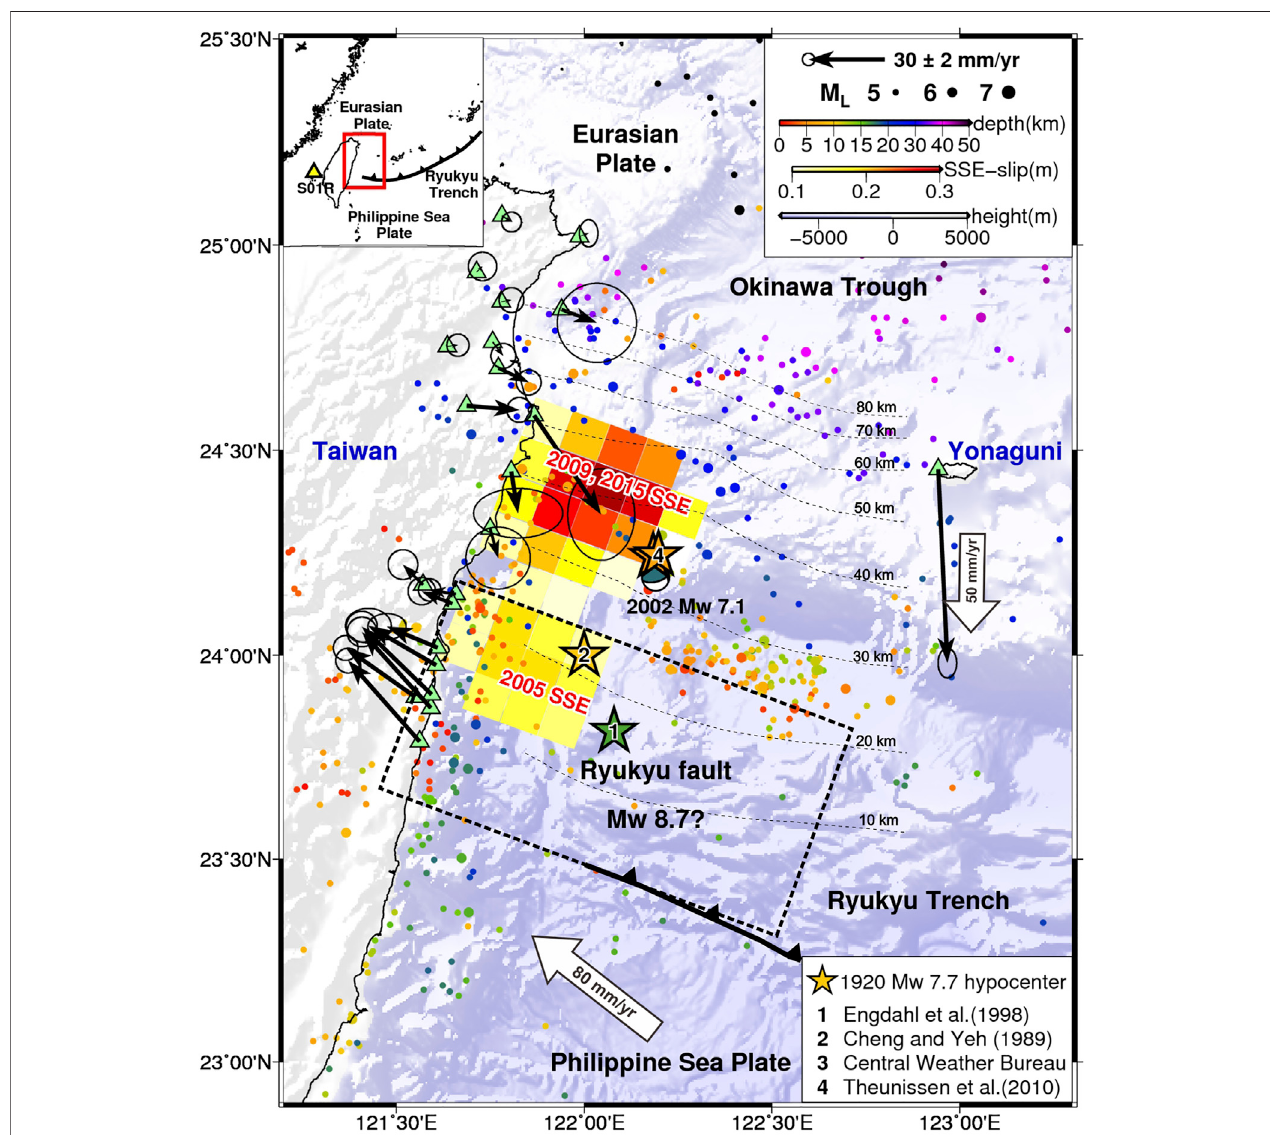
FIGURE 1| Overview of tectonics, SSEs, and seismicity in the southernmost Ryukyu subduction zone. The horizontalsurface displacement at each GNSS station (green triangles) from 2007 to 2016 indicates a movement relative to the S01R station (yellow triangle) determined by Chen et al. (2018). The dotted contours show isodepths of the 3D plate interface (Wu et al., 2009). The Ryukyu fault is marked with a dotted rectangle indicating its maximum size with a seismogenic potential of M w 8.7 (Hsu et al., 2012). Locations of the peak slip during the 2005, 2009, and 2015 slow slip events (Chen et al., 2018) are colored by the SSE-slip scale. Relocated seismicity from 1991 to 2018 based on the Central Weather Bureau earthquake catalog (Wu et al., 2008) is colored based on depth.